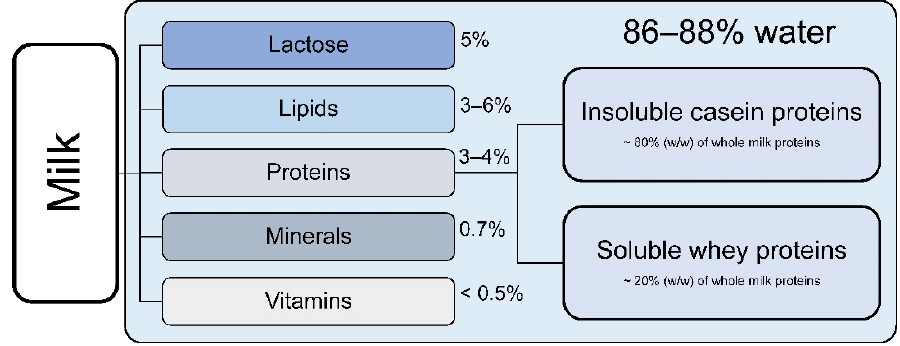
Figure 1. Approximate composition of cow’s milk. Proteins are divided into insoluble casein proteins and soluble whey proteins [18].